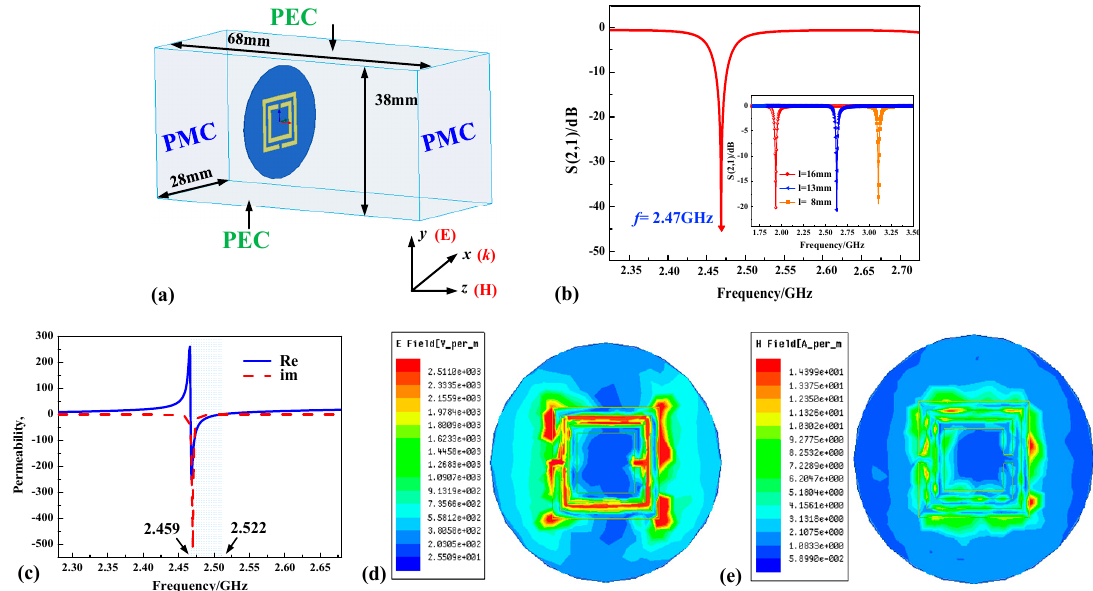
Figure 4. Simulation of the designed sensor. ( a ) Sensor modeling diagram via high-frequency simulation software (HFSS). ( b ) Transmission curve of the designed sensor. ( c ) The real and imaginary parts of the simulated magnetic permeability. ( d ) Electric field distribution of the sensor surface. ( e ) Magnetic field distribution of the sensor surface. PEC = perfect electric conductor; PMC = perfect magnetic conductor. Table 2. Performance index of alumina ceramics.